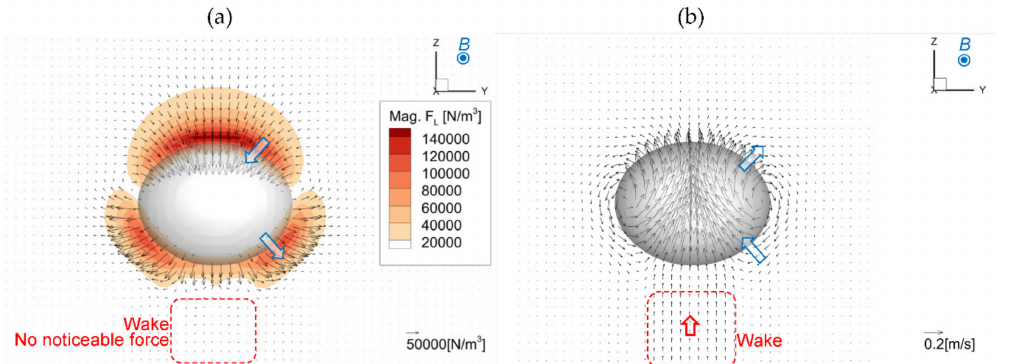
Figure 27. Distribution of ( a ) the Lorentz force vectors and ( b ) velocity vectors in the x = 0 plane for B 0 = 1.12 T. In the wake, noticeable Lorentz force was not observed, i.e., the Lorentz force does not decelerate the flow velocity. The bold arrows (blue and red) represent the main feature of the flow velocity, and the frame drawn with red, dashed line indicates the wake.